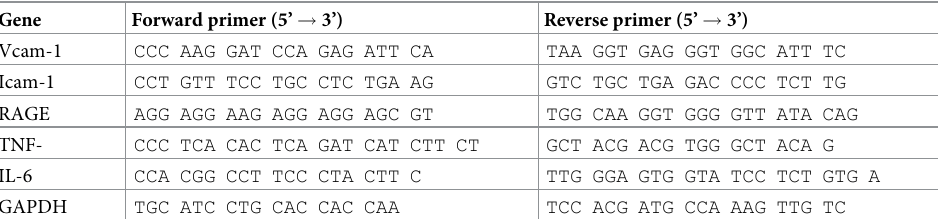
Table 1. Primer sequences and real-time PCR